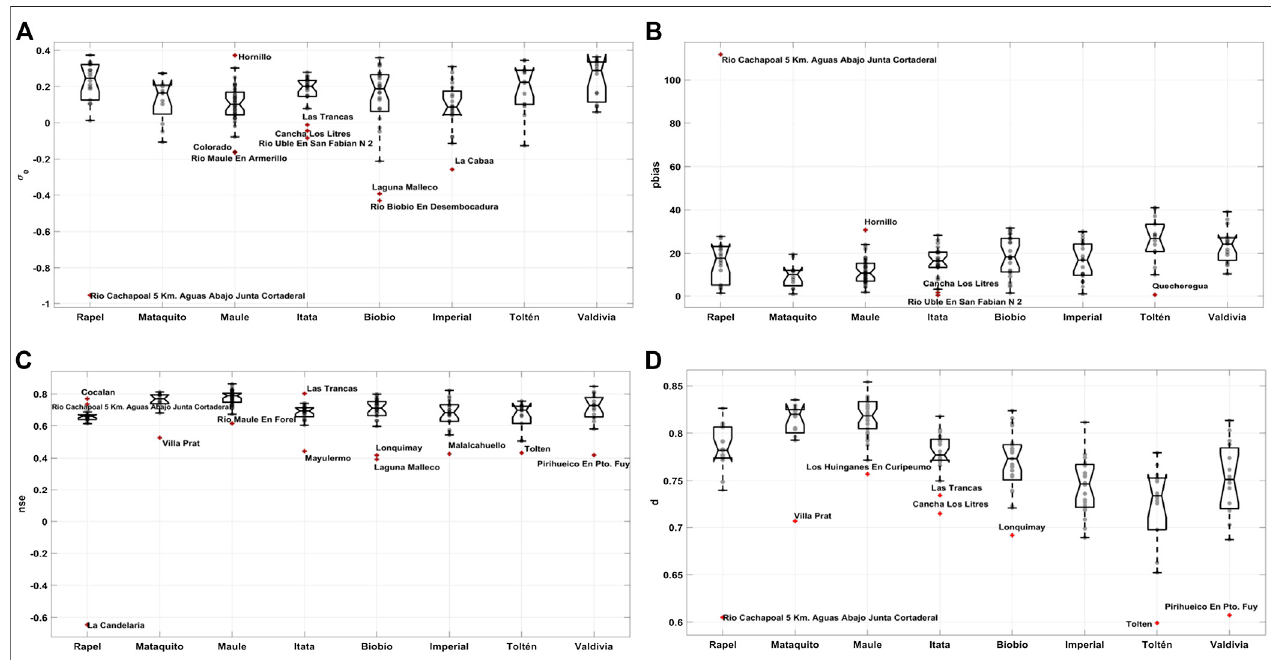
FIGURE7| Boxdiagramscorresponding tothe fi toftheweatherresearchandforecasting model,onceadjusted( Eq.1 )ontheriverbasinsoftheareaunderstudy ( Figure 1B ). (A) Standardized standard deviation ( σ e ) , (B) percentage of the systematic error ( pbias ) , (C) Nash – Sutcliffe coef fi cient ( nse ) , and (D) Willmott coef fi cient ( d )